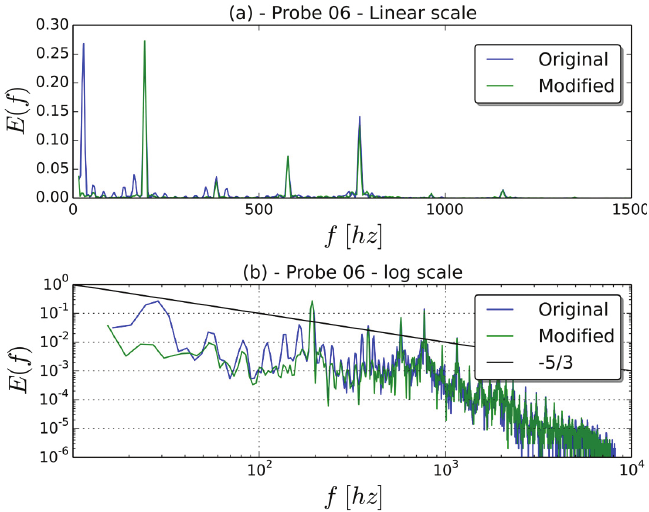
Figure 35 - Energy spectra for probe 6; (a) : in linear scale; (b) : log scale.